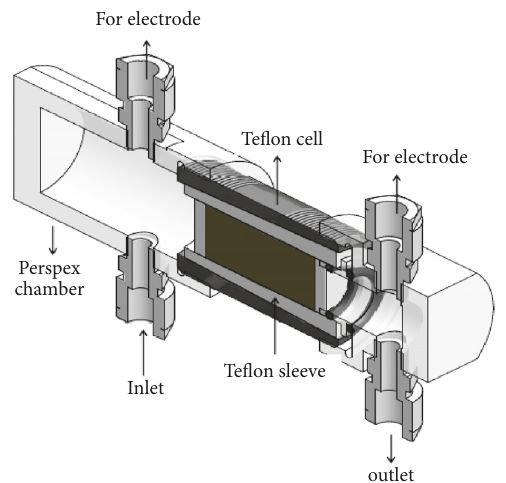
Figure 6: The core